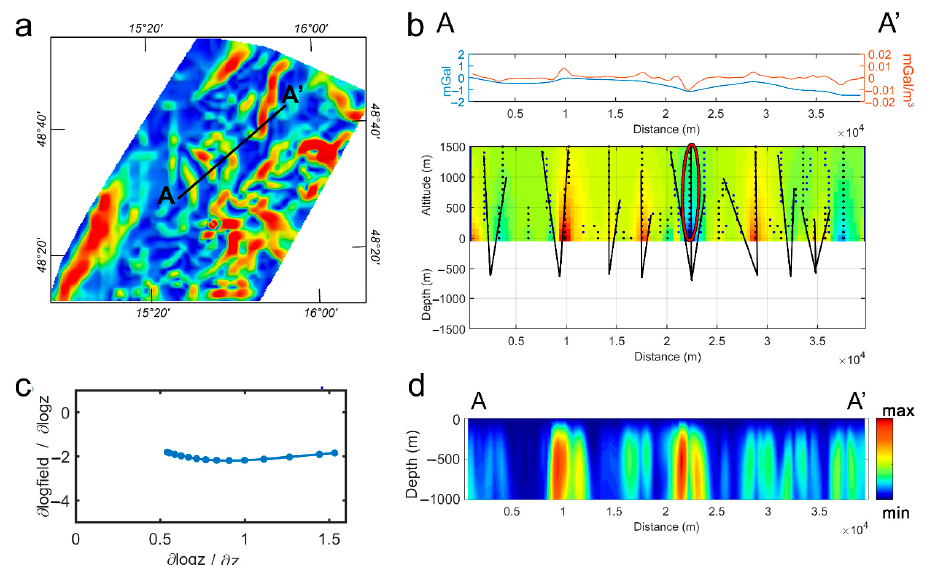
Figure 8. Structural index and depth estimation for gravimetric data: ( a ) EHD map highlighting lineaments with overlaid the profile chosen for our analysis; ( b ) ridges relative to the 3rd derivative of the gravity field computed along the profile AA’; ( c ) evaluation of the SI N by the scaling function analysis; ( d ) 2D imaging of the sources of the area on horizontal gradient of gravity data along the chosen profile; the depth to the sources is shown by the maxima of the DEXP signal (normalized dimensionless units are used).